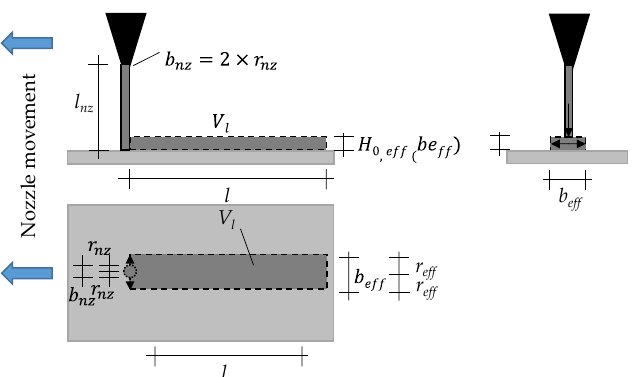
Figure 9. Application of the cement paste during printing process; b nz : diameter of the nozzle; r nz : Radius of the nozzle; l nz : height of the nozzle; H 0,eff : effective height of the cement paste (strand); b eff : width of the cement paste (strand) immediately before penetration, r eff : Halved width (radius) of the cement paste (strand) immediately before penetration; l: length of the strand; V l : Applicated volume.